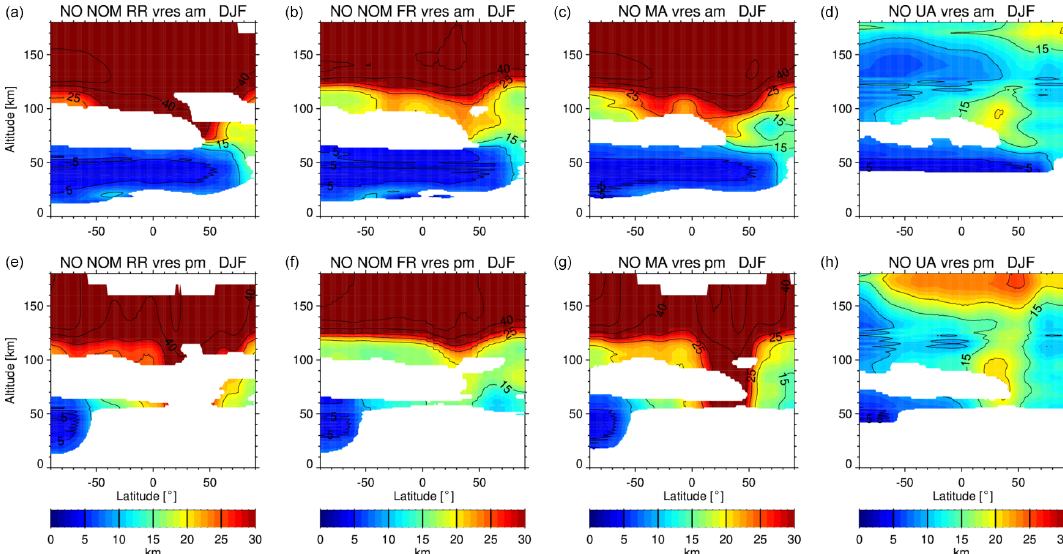
Figure 2. Zonal mean vertical resolution (in terms of full width at half maxima of the AK rows) of NO during the northern winter season (December–February, DJF) from NOM RR measurements, NOM FR measurements, MA measurements, and UA measurements as a func- tion of latitude and altitude, separated for (top) morning and (bottom) afternoon. White areas indicate data with insignificant information content (AK diagonal < 0.03). Note that NOM FR measurements are averaged over the 2002–2004 period, while measurements from other observation modes and periods are averaged over the 2006–2012